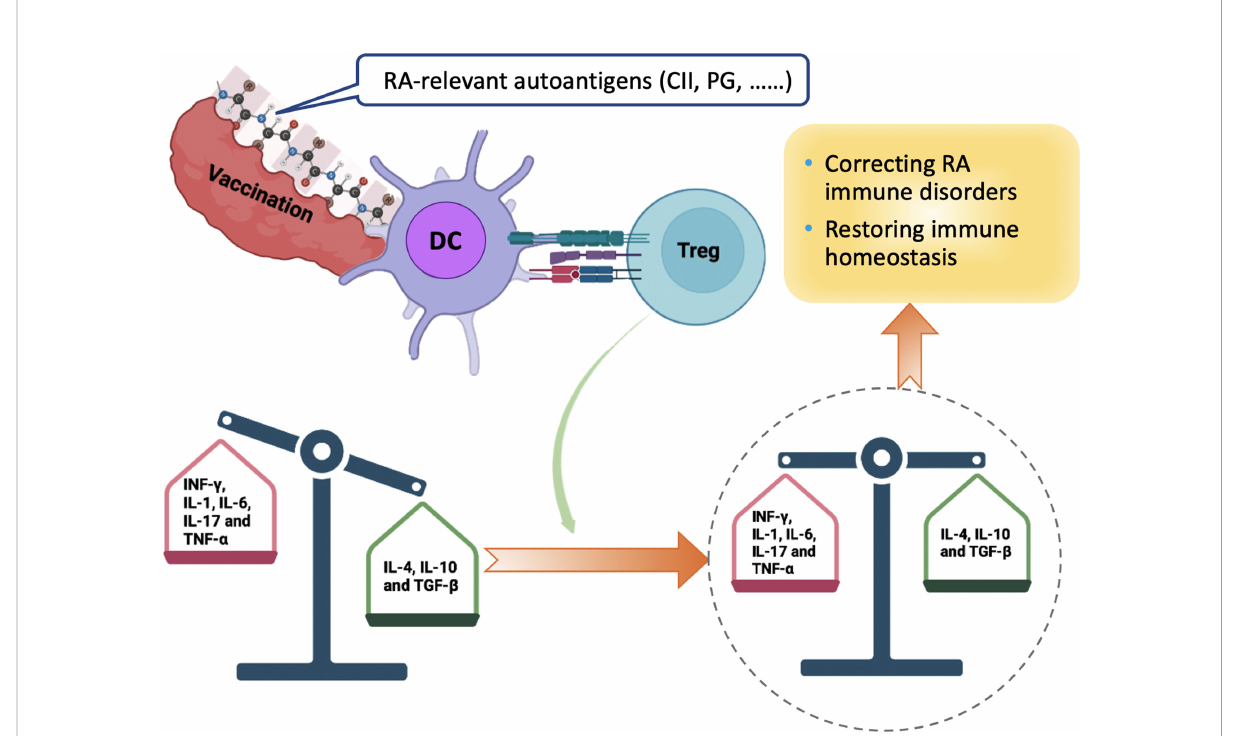
FIGURE 3 Mechanism of Peptide-based tolerogenic vaccination to Induce the Immune Homeostasis in RA Treatment. Vaccine containing autoantigens related with RA can be processed by DC and presented to Tregs in the context of TCR and cytokines. Activated Tregs function as the main regulator of the immunosuppressive process by increasing the ratio of anti-in fl ammatory cytokines (green box), restoring immune homeostasis and modulating the balance between pro-in fl ammatory (red box) and anti-in fl ammatory cytokines. CII, type II collagen; PG, proteoglycan; DC, dendritic cell; INF, interferon; Tregs, regulatory T cells; TGF, transforming growth factor; TNF, tumor necrosis